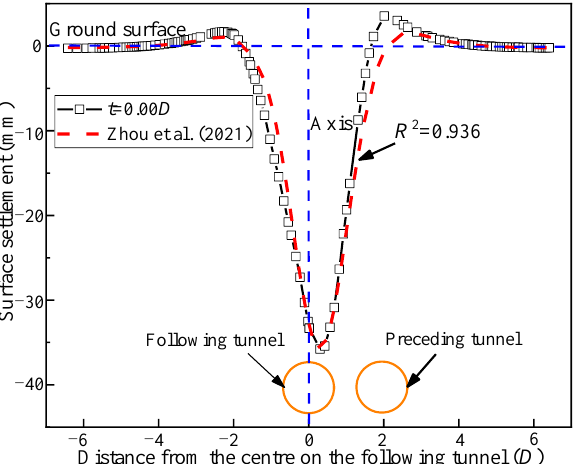
Figure 4. Comparison between numerical and analytical results [37].